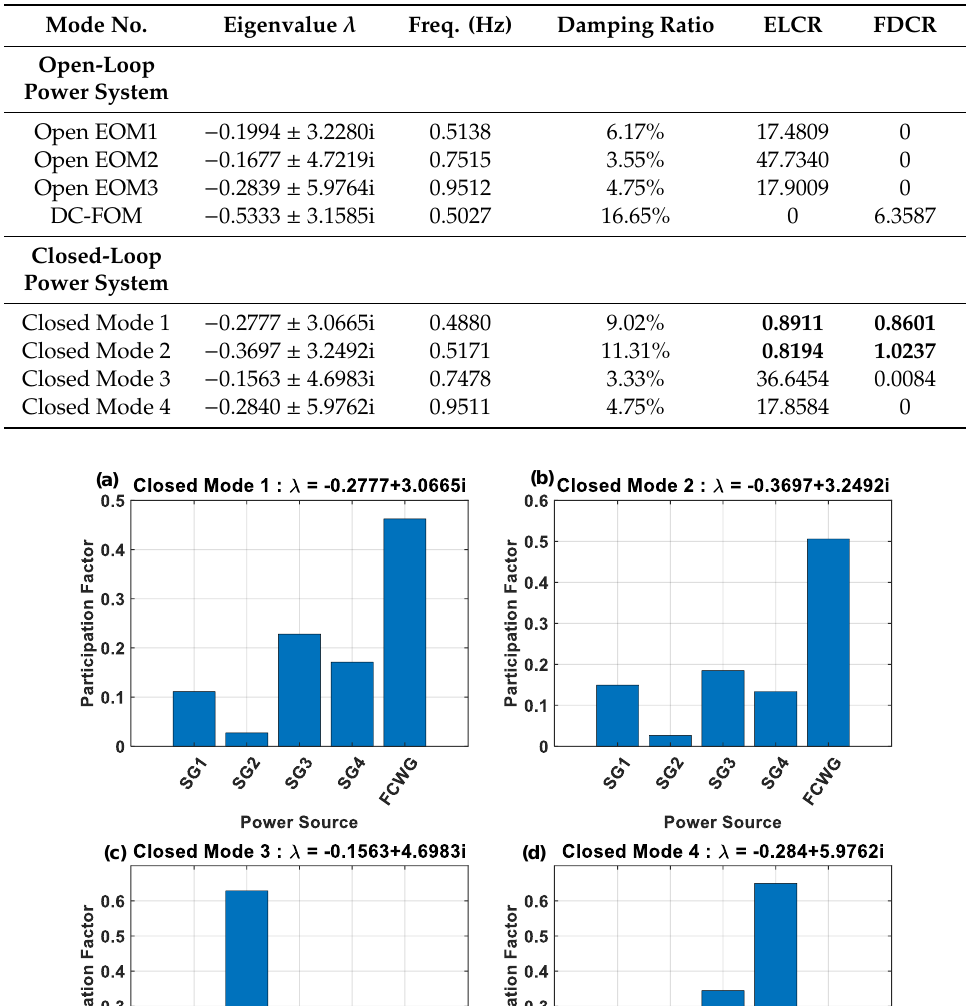
Table 4. EOMs of two-area power system in Scenario 10 (Pew = 86%).